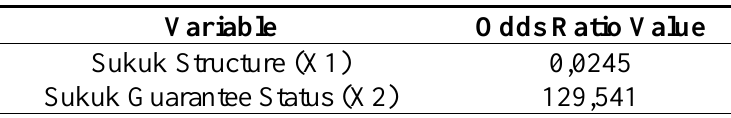
Table 8. Result of odd ratio value